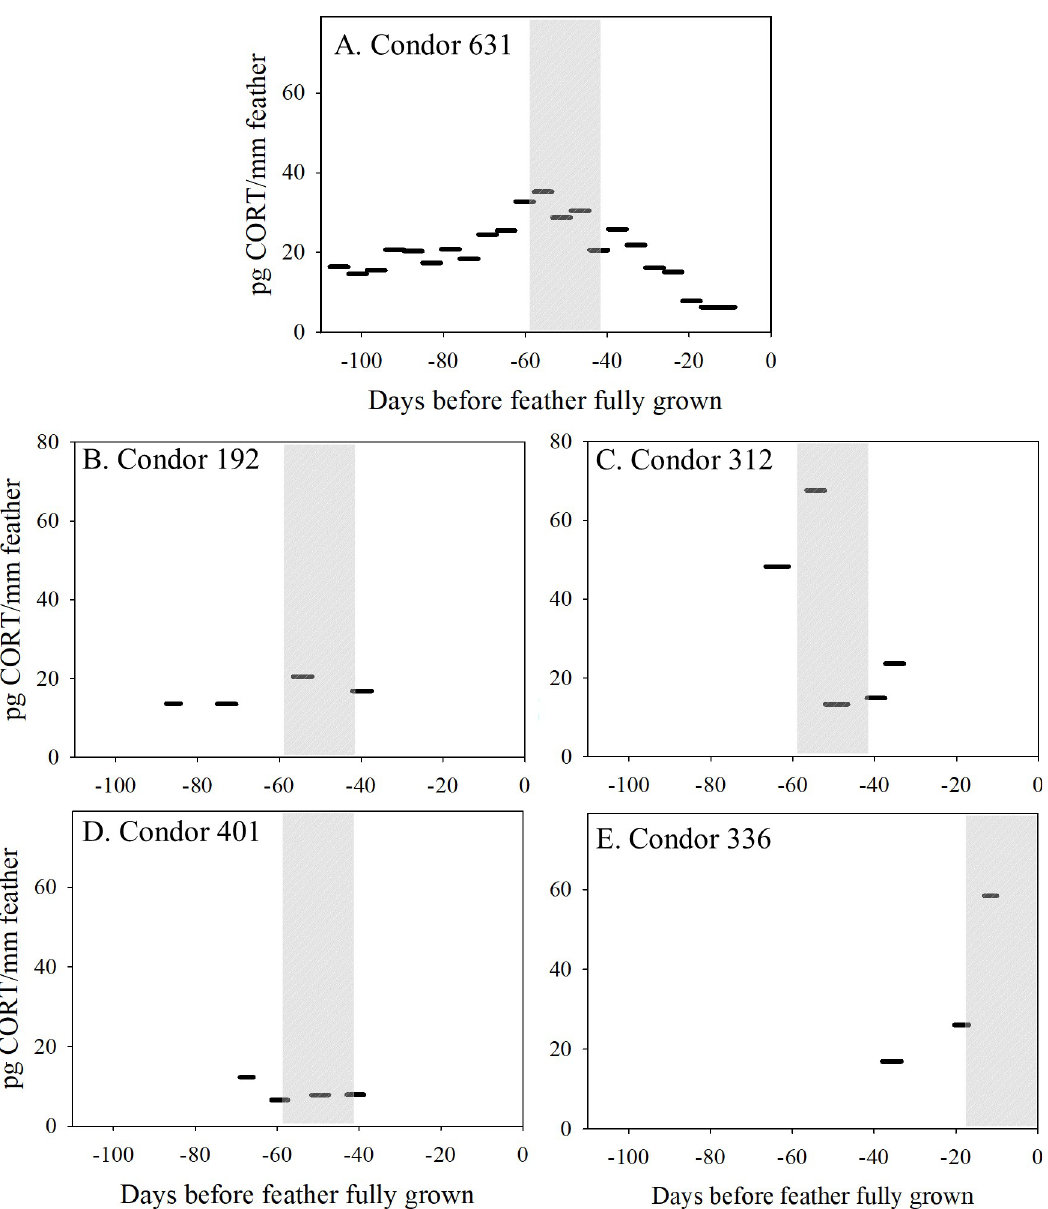
Fig 4. Feather section corticosterone (CORT) concentrations vary over the period of feather growth in free-flying California condors. CORT concentrations measured in sections of flight feather (2 cm lengths along rachis axis) collected from five individual wild condors. (A) Contiguous 2 cm sections from condor 631’s #6 primary feather show changes in CORT concentrations over the time of feather growth. (B-D) Non-contiguous #3 primary feather sections from condors 192, 312, and 401 show changes in feather CORT concentration over time of feather growth and variation between birds. (E) Retrix (tail) feather CORT levels from condor 336, who died of lead poisoning while receiving clinical treatment (feather growth day 0). The estimated duration (days) of feather section growth is represented for each section by the width of each section line, determined using a primary feather growth rate of 4.4 ± 0.28 mm/day in California condors [28] (See S2 Table for details). Total CORT per feather section (pg) is normalized to feather section length (mm along rachis axis) to represent integrated plasma CORT levels over time of feather section growth [33,46].Grey shaded area indicates timing of the estimated 18 day period within which the condor was trapped, held captive in a flight pen, and